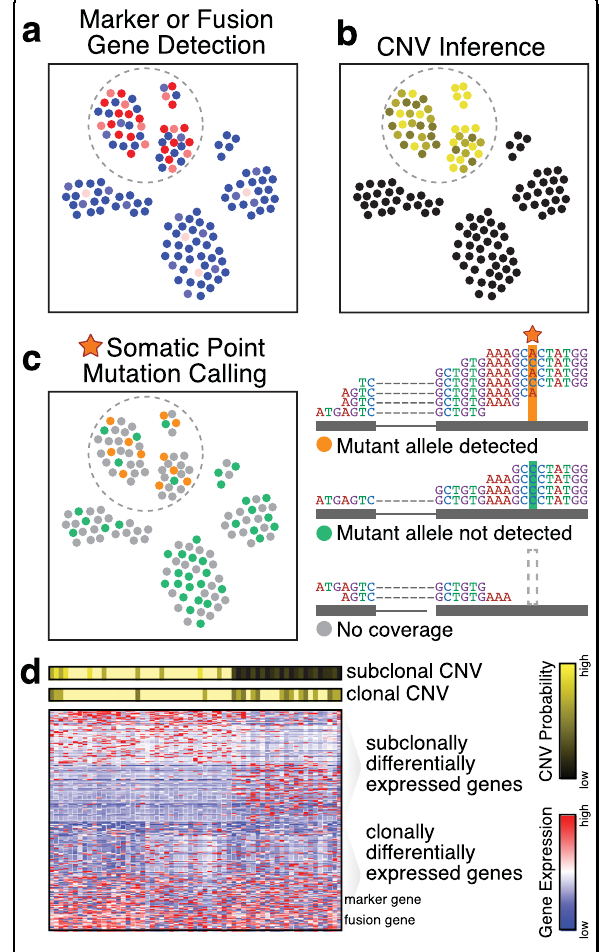
Fig. 4 Distinguishing neoplastic and nonneoplastic cells. a The detection of marker or fusion genes that are uniquely upregulated or expressed in neoplastic cells may be used to identify neoplastic cells. In this illustration, many neoplastic cells exhibit high expression (red) of a marker or fusion gene, although dropouts or other technical factors result in the detection of low or no expression (blue) in other neoplastic cells in the same cluster. b Copy-number variant (CNV) inference may also be used to identify neoplastic cells. Normalized smoothed gene expression magnitudes and variant allele frequencies can be used to infer the probability that a cell harbors CNVs. Neoplastic cells exhibit higher probabilities of harboring any CNVs, as expected. c Somatic point mutation calling may be used to identify neoplastic cells. The top read pileup for a cell shows an example in which both the mutant and reference alleles are detected, indicating that the cells harbors the mutation. The middle read pileup for a cell shows an example in which the mutant allele is not detected, which could indicate that the cell does not harbor the mutation or that there is allelic dropout of the mutant allele. Alternatively, the bottom read pileup shows an example where the mutation site presents no read coverage, and thus, no mutation call can be made. d The inference of CNVs and other genetic alterations directly from RNA-sequencing data enables the direct interrogation of transcriptional differences among genetic subclones. A clonal CNV distinguishes neoplastic from nonneoplastic cells and is also marked by high expression of marker and fusion genes. In addition, a subclonal CNV is present. Differential expression analysis may be applied to directly identify differentially expressed genes between genetic